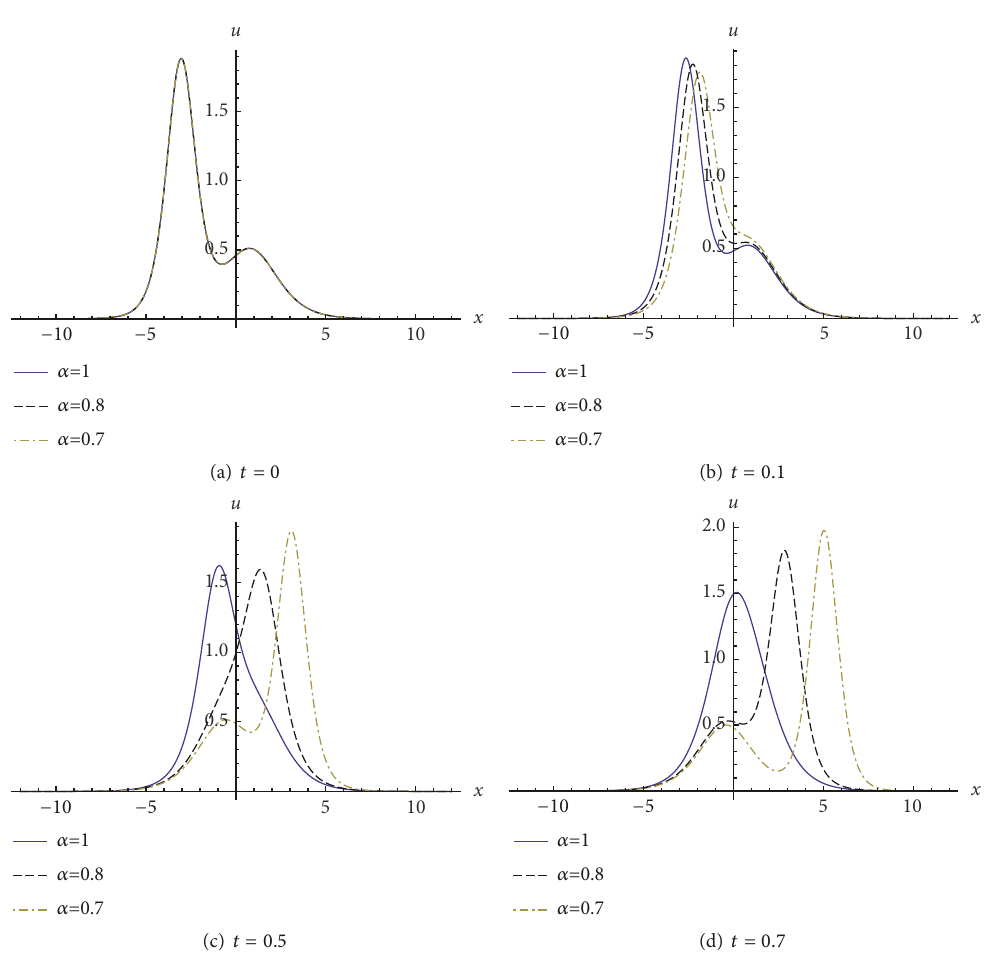
Figure 5: Dynamical evolutions of fractional two-solitons determined by solution (44) at different times.